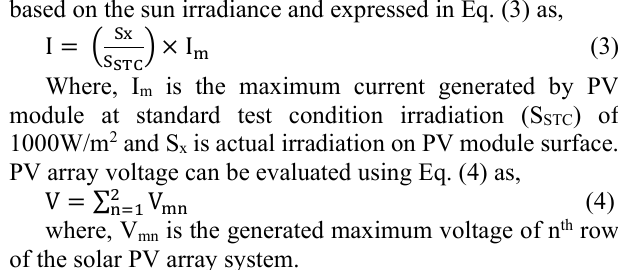
Deliberated current of solar cell (